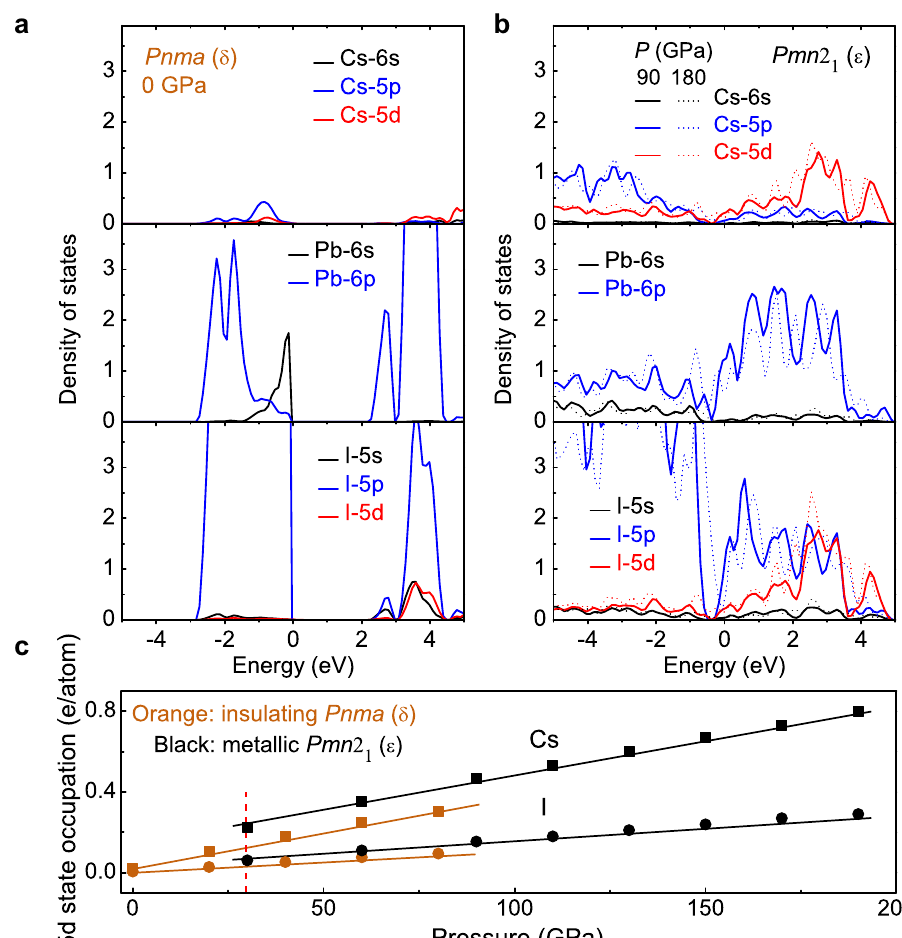
Fig. 4 | Electronic structure of CsPbI 3 at representative pressures. a Density of statesofthe δ phaseat0GPa.Theblack,blue,andredlinesrepresentthes,p,andd states, respectively. b Density of states of the ε phase at 90GPa (solid lines) and 180GPa(dashedlines). c The 5dstateoccupationof the Cs(squares)and I(circles)